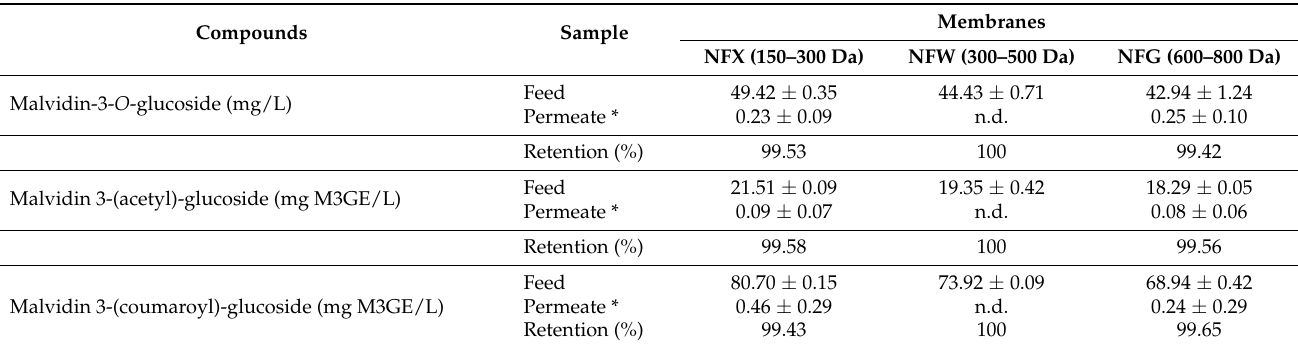
Table 2. Anthocyanins content in the feed and permeate stream of investigated NF membranes (M3GE, malvidin-3-glucoside equivalents) after 180 min of process.